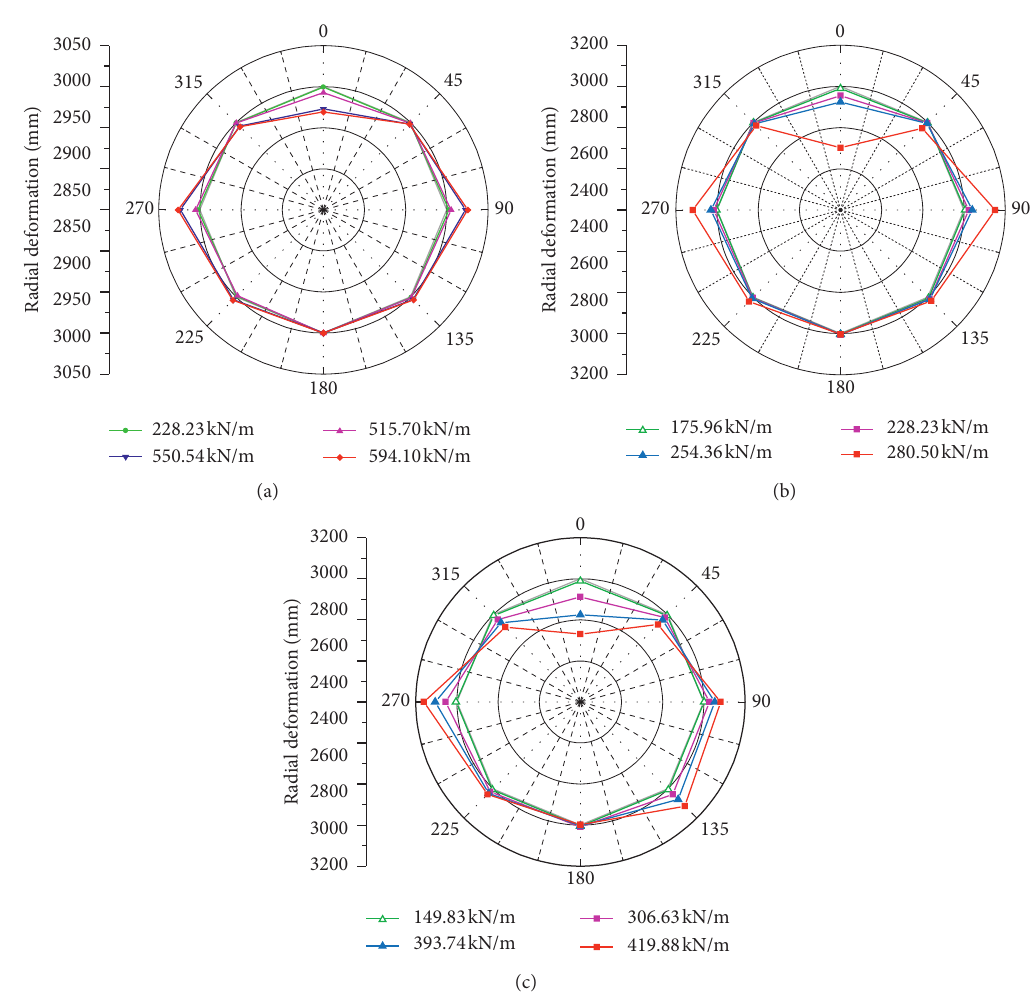
Figure 13: The deformed shape of lining models. (a) Uniform rings. (b) Straight-jointed rings. (c) Stagger-jointed